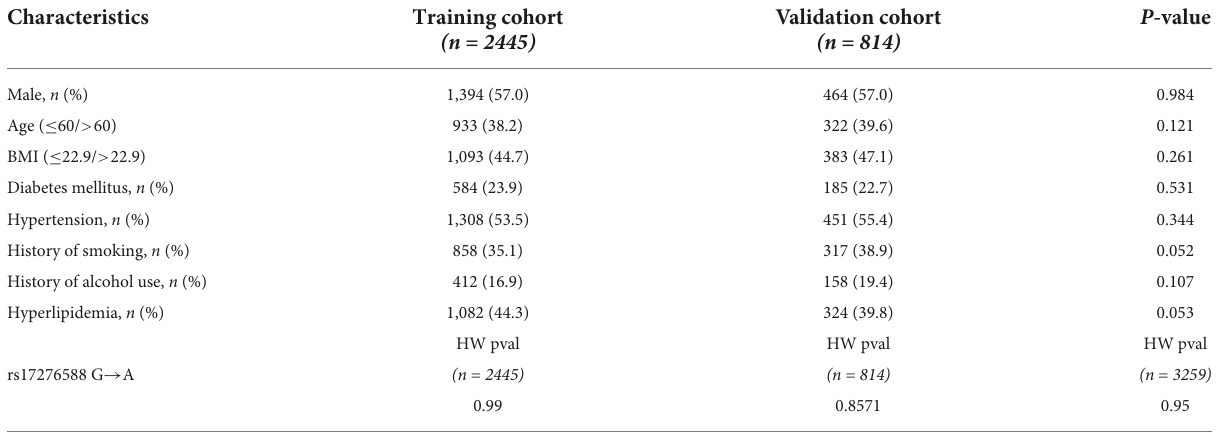
TABLE 2 Clinical and demographic characteristics of the patients in the training and validation cohorts. Characteristics